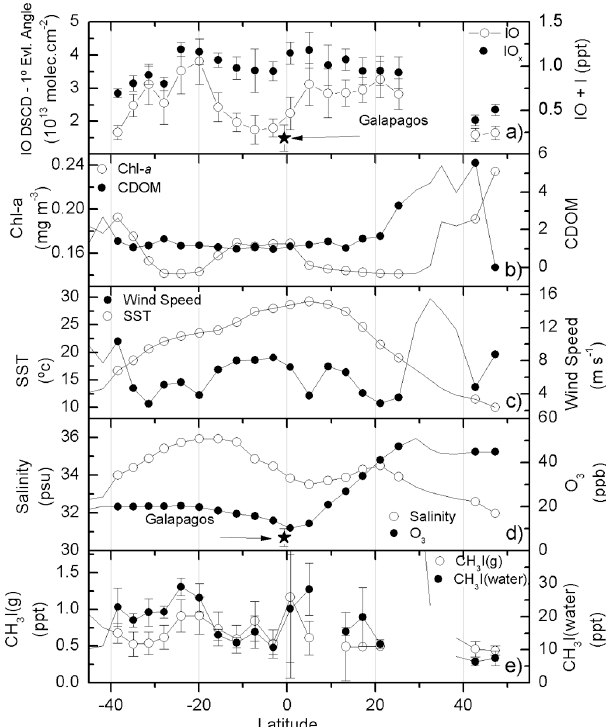
Fig. 5. Latitudinal distribution of IO DSCDs, calculated total reac- tive iodine IO x (I+IO) and other parameters measured during the cruise. Circles are shown only when IO was observed above the de- tection limit. Note that IO DSCD and [O 3 ] observations made on the same day of the year (in 2011) during an ongoing ground-based field study on the Galapagos Islands, indicated as stars, are in accord with observations at the same latitude during the cruise. Circles are shown only when IO was observed above the detection